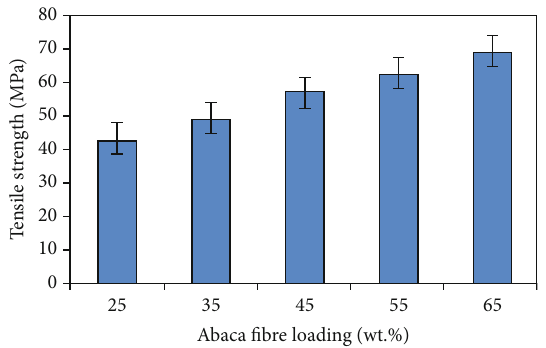
Figure 3: Tensile strength (MPa) vs abaca fi bre loading (wt %). Table 1: The specimens ’ tensile strength. Loading of abaca fi bre (wt